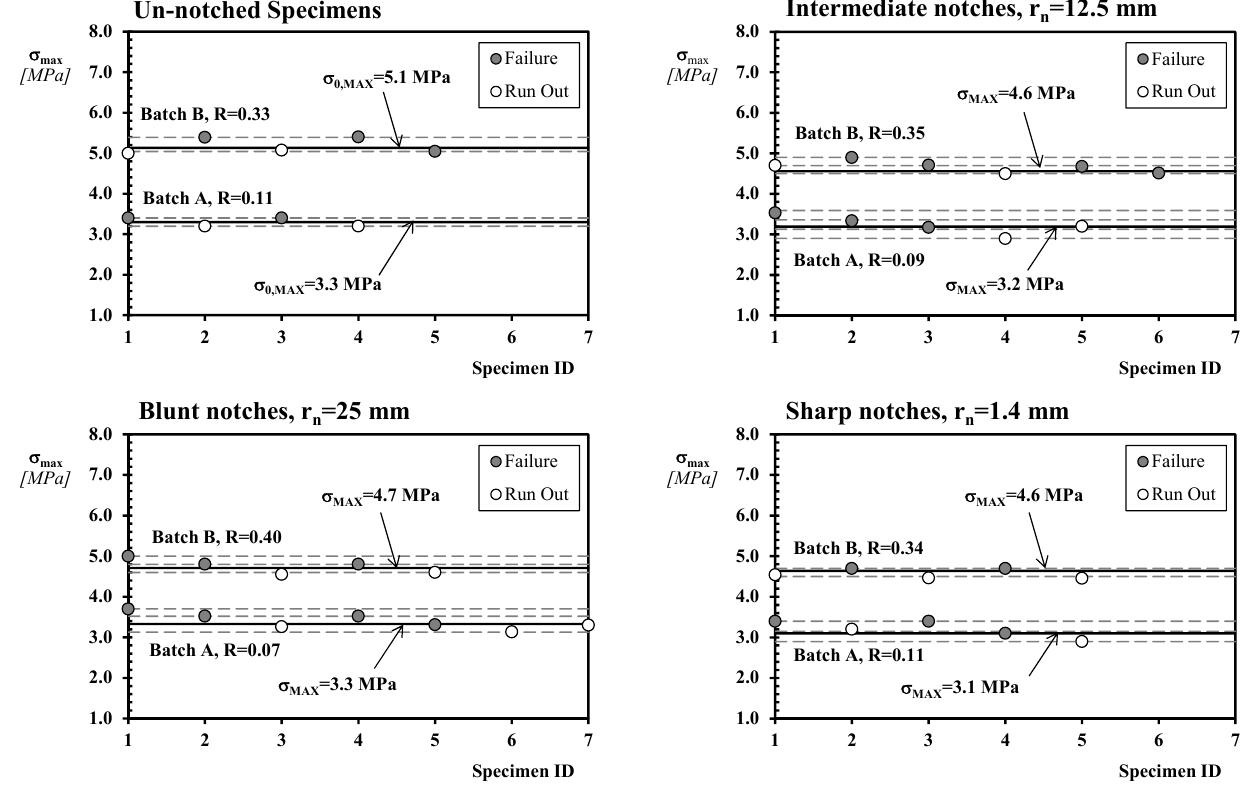
Figure 1: Summary of the generated fatigue results and endurance limits estimated according to Dixon’s technique